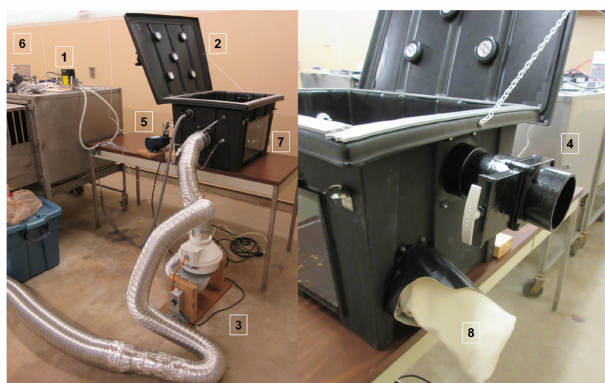
Figure 1. Setup of the gas chamber for Experiment 1. The two treatment gases (CO 2 and N 2 O) went from the tanks to the mass flow controllers (1), into the chamber box (2), and then out of the chamber with help from a ventilator (3) and a gate valve that allowed the system to be flushed (4). A vacuum pressure pump (5) kept the system under a slight negative pressure that was measured by a manometer (6). Acrylic glass (7) allowed visualization of the piglets. To check for palpebral reflexes there was a glove assembly (8) for reaching into the chamber.